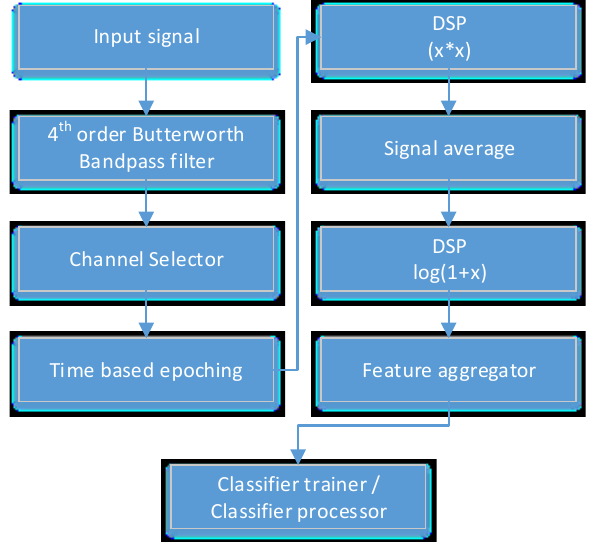
Fig. 7. Block diagram of signal processing during the experiments, made in OpenVibe system.